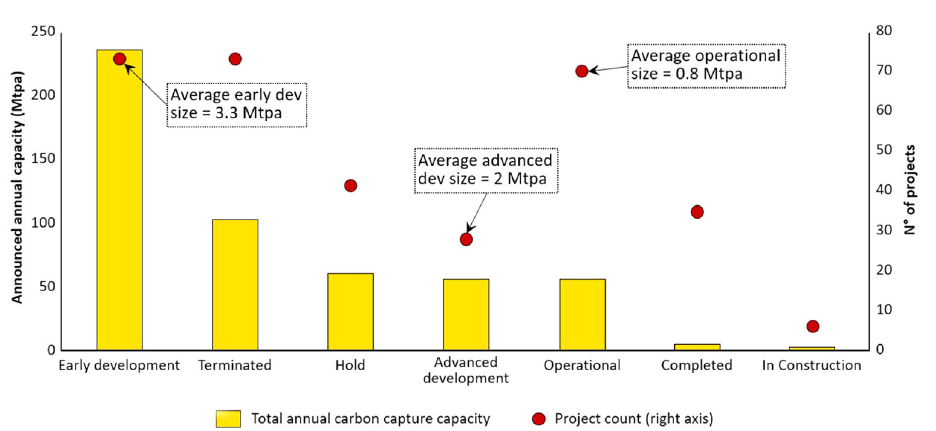
Fig. 4. – CCS projects development status in terms of capacity (left axis) and number (right axis). Please note the increase of average size per project moving from “Operational” to “Early development” [1].